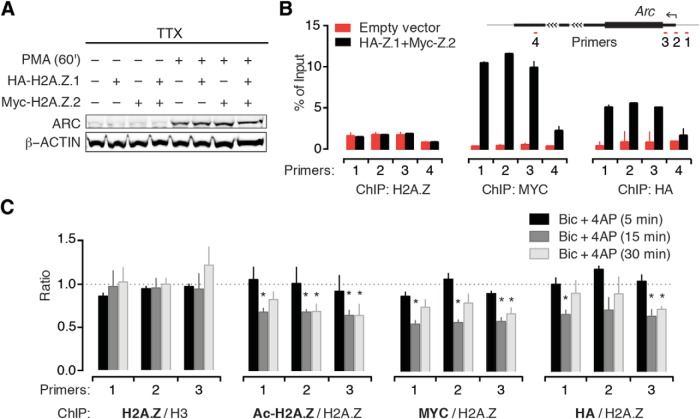
Both H2A.Z hypervariants are present near the Arc TSS and mediate its transcription. A, Representative Western blotting of whole-cell lysate from neurons infected as indicated for 5–6 d. Neurons were treated with TTX + PMA for 60 min to assess ARC expression. N = 3. B, top, Graphical map (not to scale) depicting relative position of ChIP primers near Arc TSS. Bottom, Quantification of H2A.Z, MYC-H2A.Z.2, and HA-H2A.Z.1 binding to the Arc TSS region in untreated neurons as determined by ChIP with antibodies against H2A.Z, MYC, and HA epitopes. N = 4. C, Quantification of H2A.Z, Ac-H2A.Z, MYC-H2A.Z.2, and HA-H2A.Z.1 binding to Arc TSS region in neurons treated with Bic + 4AP for indicated time periods. N = 4. Data are normalized as indicated and expressed as fold change compared to untreated samples (denoted by the broken line at 1 on y-axis).